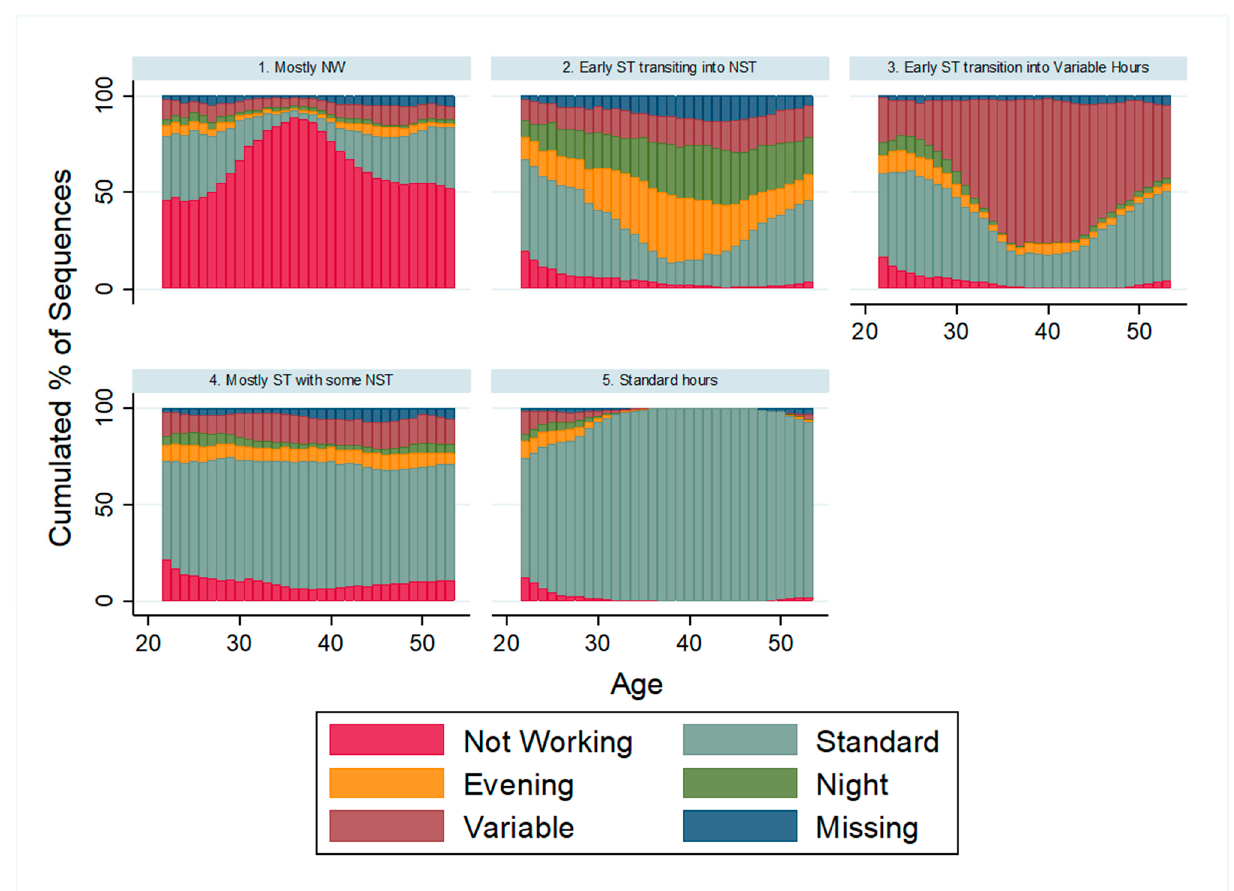
Figure 1. Distribution Plot of the Five Clusters. Table 1. Descriptive Statistics for Overall Sample and by Cluster.